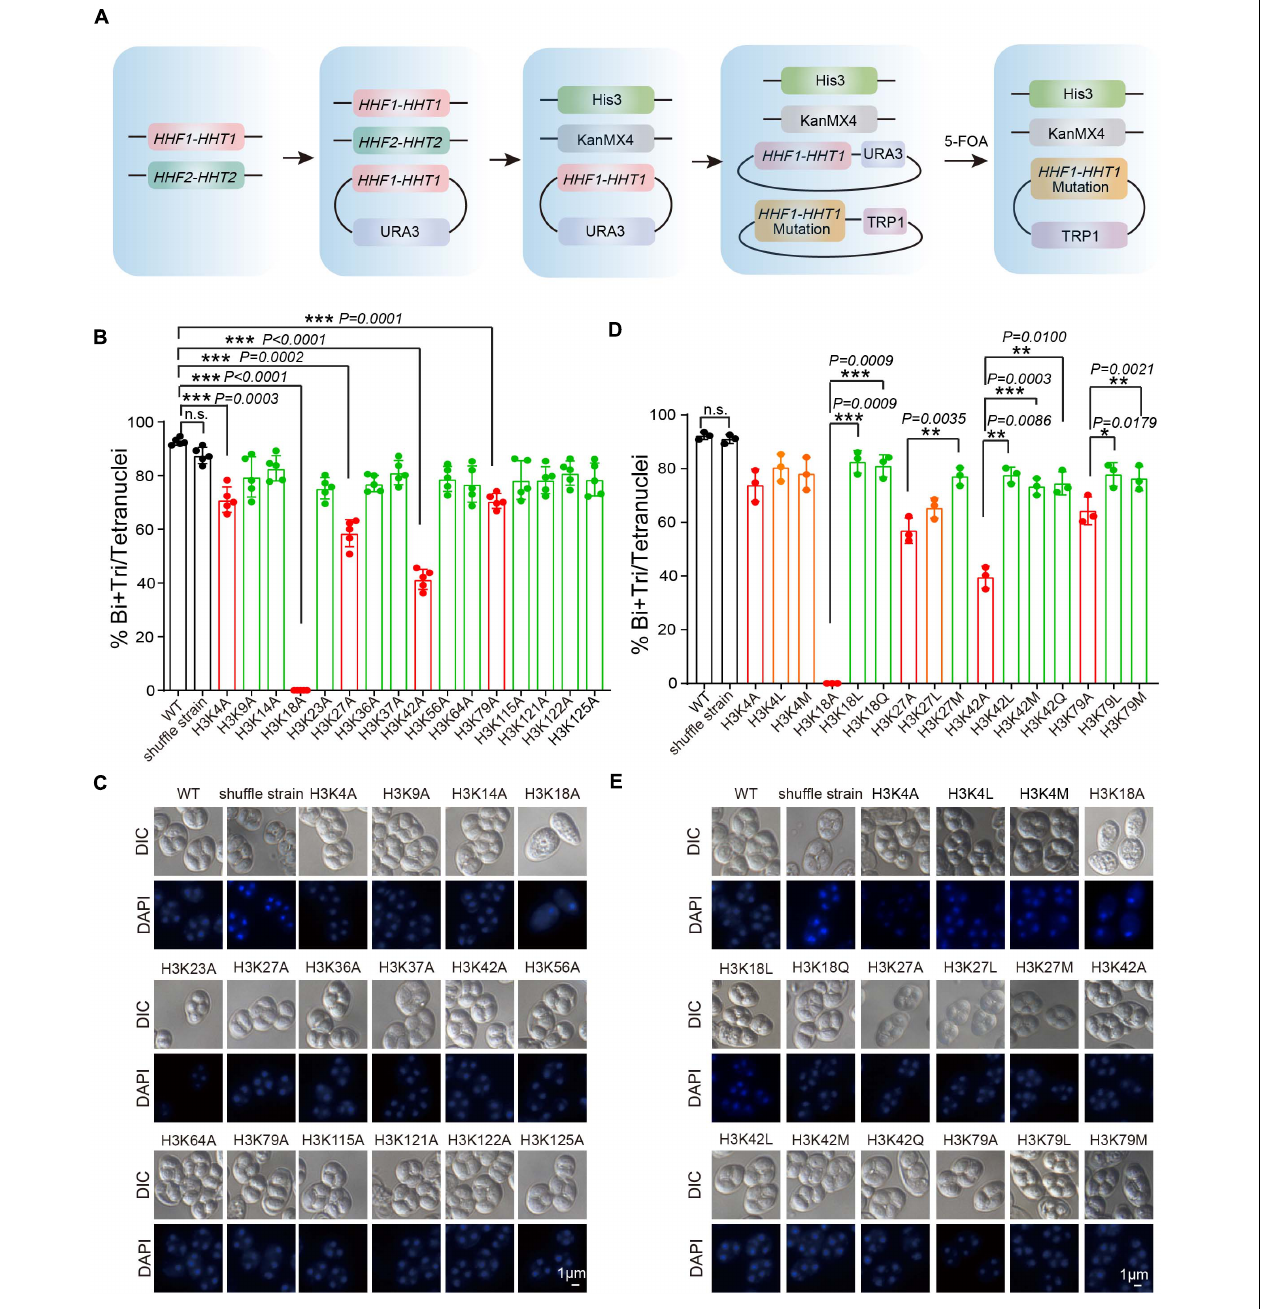
FIGURE 3 | Systematic screen of H3 lysine modifications needed for sporulation. (A) H3 mutant strains were generated using an SK1 background. Endogenous histone H3 and H4 genes were knocked out, and the cell (LW1599) was transfected with a plasmid which had an Myc- HHF1-HHT1 -HA and a URA3 selection marker. Then, another plasmid with histone H3 point mutation was transfected and 5-FOA negative selection was used to replace the original plasmid. (B) Sporulation efficiency of histone H3 K to A mutant strains. The error bars indicate ± SD ( n = 5). *** P < 0.001. n.s. indicates no significant. WT: LW0066; shuffle strain: LW1599; H3K4A: LW1600; H3K9A: LW1601; H3K14A: LW1602; H3K18A: LW1603; H3K23A: LW1604; H3K27A: LW1605; H3K36A: LW1606; H3K37A: LW1607; H3K42A: LW1608; H3K56A: LW1609; H3K64A: LW1610; H3K79A: LW1611; H3K115A: LW1612; H3K121A: LW1613; H3K122A: LW1614; H3K125A: LW1615. (C) Images of nuclei from cells in B . (D) Sporulation efficiency of mutant cells mimic different histone modifications. The error bars indicate ± SD ( n = 3). * P < 0.05, ** P < 0.01, *** P < 0.001. n.s. indicates no significant. WT: LW0066; shuffle strain: LW1599; H3K4A: LW1601; H3K4L: LW1616; H3K4M: LW1617; H3K18A: LW1603; H3K18L: LW1622; H3K18Q: LW1623; H3K27A: LW1605; H3K27L: LW1624; H3K27M: LW1625; H3K42A: LW1608; H3K42L: LW1626; H3K42M: LW1627; H3K42Q: LW1628; H3K79A: LW1611; H3K79L: LW1629; H3K79M: LW1630. (E) Images of nuclei from cells in D .